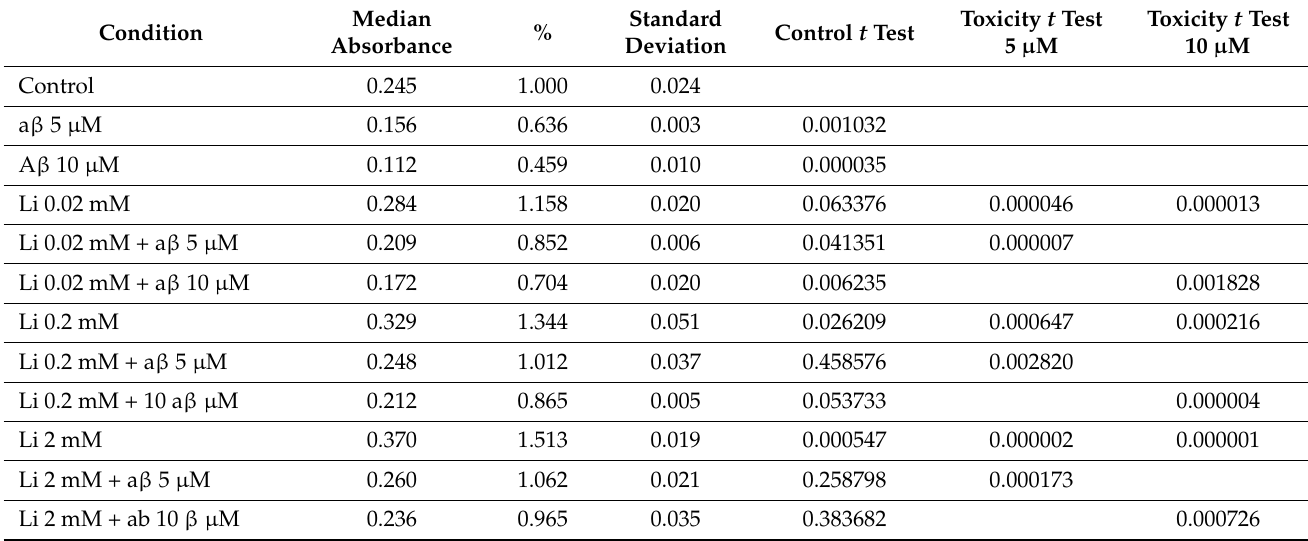
Table A1. Absorbance in cortical cultures.